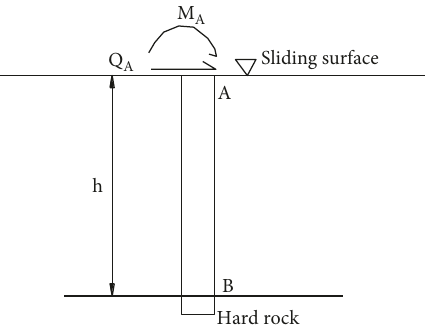
Figure 7: Distribution of axial strain peaks of the anchor cable against the pile top displacement. Table 4: Physical and mechanical parameters of the studied